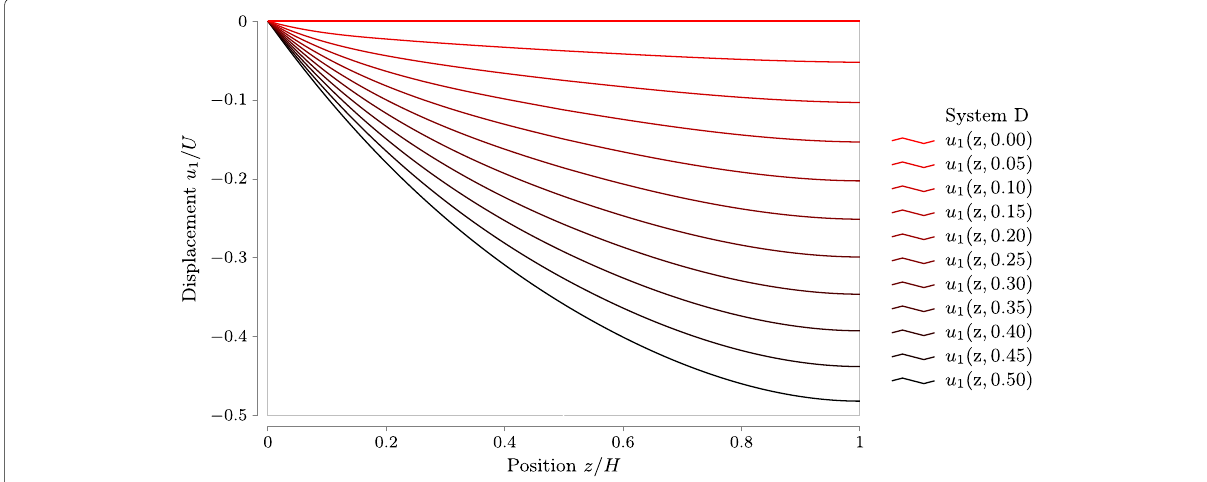
Fig. 9 MATLAB simulation of u 1 ( z , t ) for t ∈ { 0,0.05, ... ,0.45,0.50 } for A 1 = A 2 = 0 and the other parameters with the values of Table 1. The oscillations in the graphs are due to an unphysical alternating-in-time solution of v 3 ( z , t ) in the MATLAB simulation